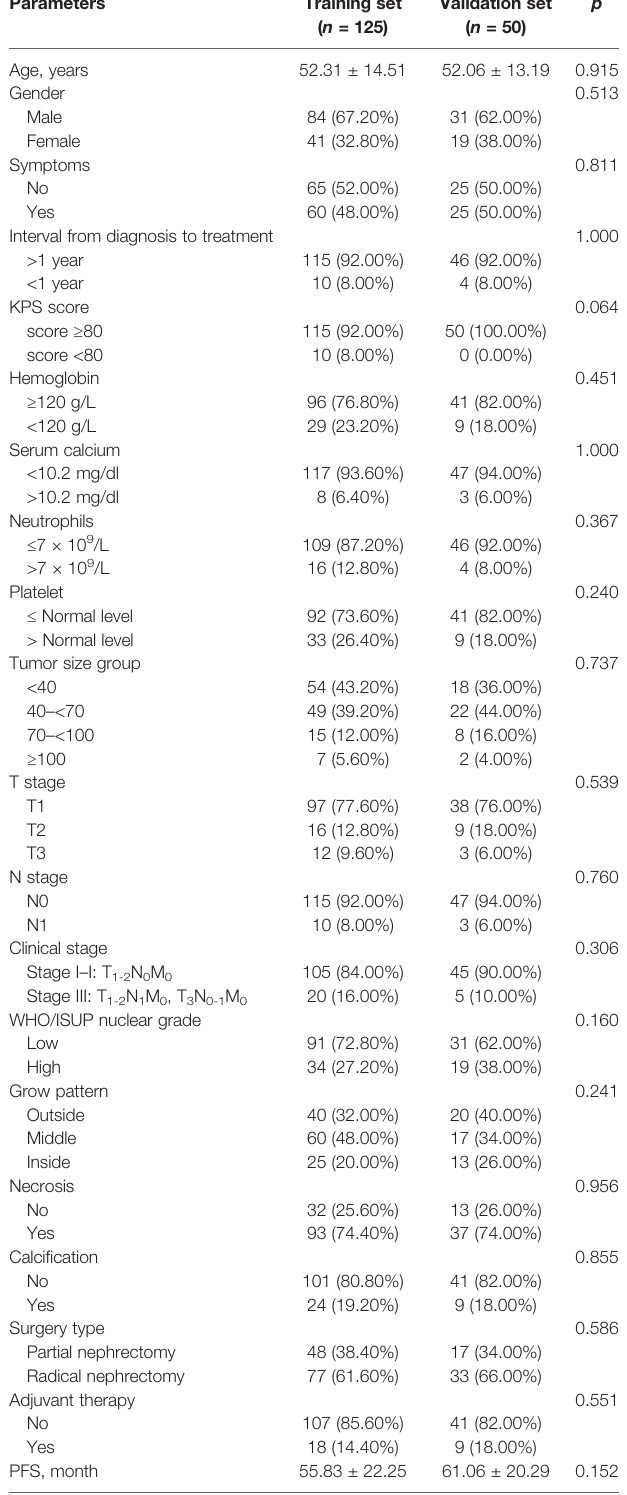
TABLE 1 | Patient ’ s clinical characteristics between training set and validation